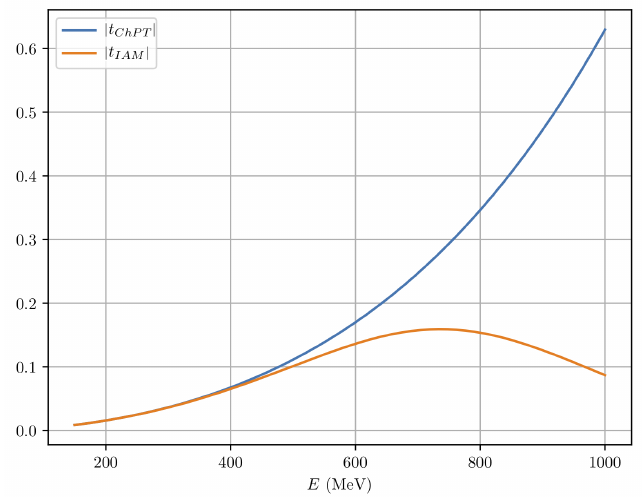
and t at O ( p 4 ) for the IJ = 11 ChPT IAM